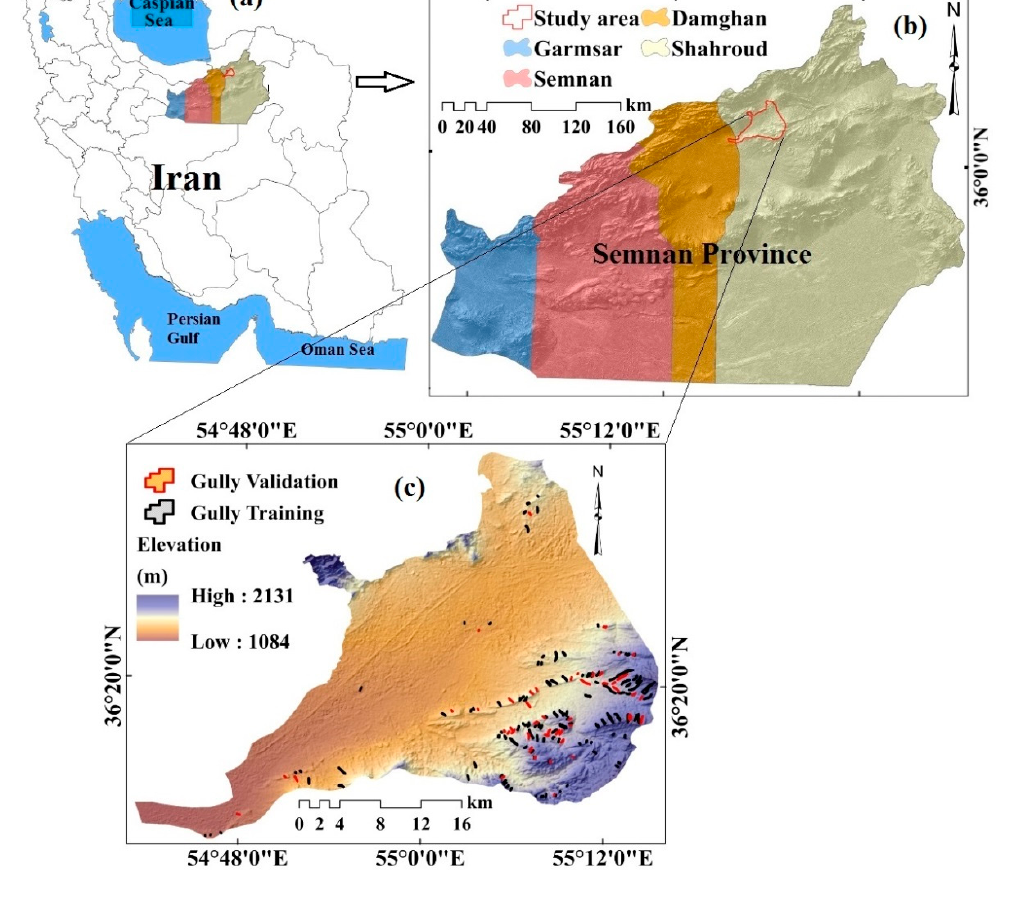
Figure 1. ( a ) Location of the Semnan provinces in Iran, ( b ) location of study area, and ( c ) gully erosion locations with the digital elevation model map of the Shahroud watershed.